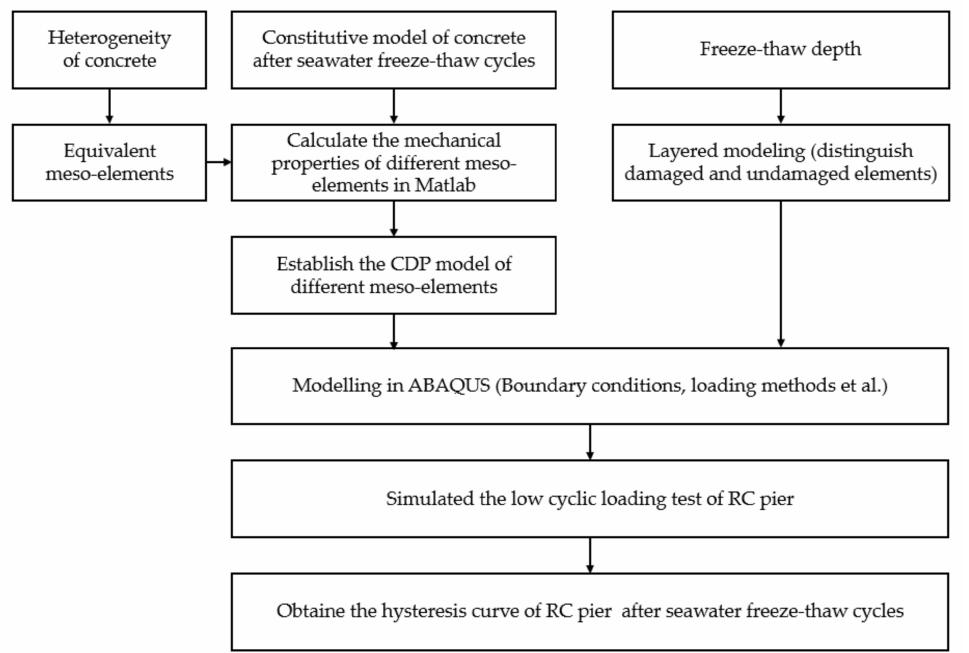
Figure 28. Flowchart of the whole numerical analysis process. The comparison between simulation results and experimental results is shown in Figure 29. The hysteretic curves obtained by numerical simulation were full, and the pinching effect was good, which could reflect the various stages of the low cyclic loading test on RC piers after seawater freeze–thaw